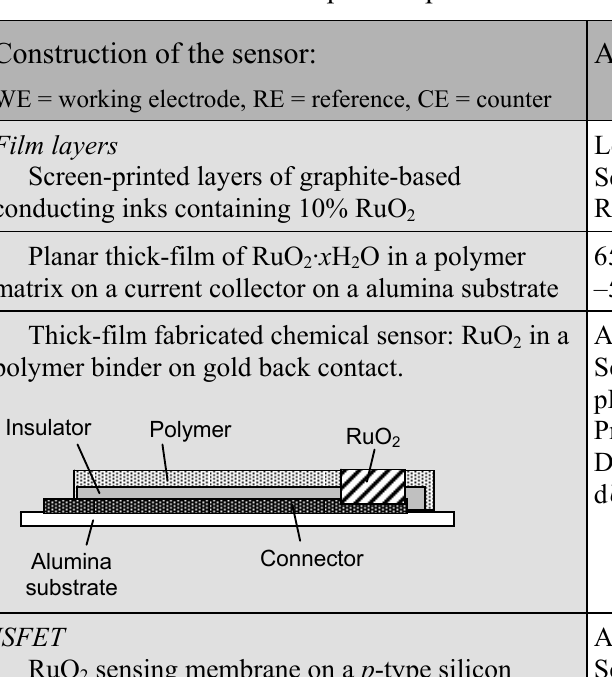
Table 5. Examples for pH sensors and measuring techniques based on RuO 2